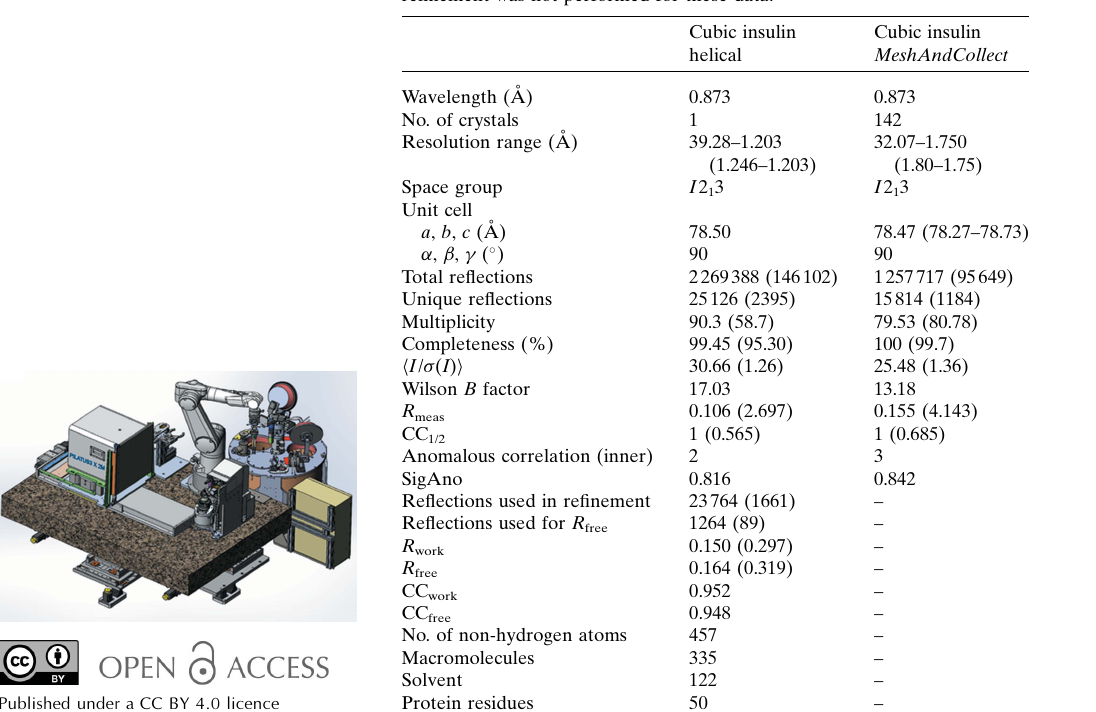
were found to be incorrect. The full correct table is shown